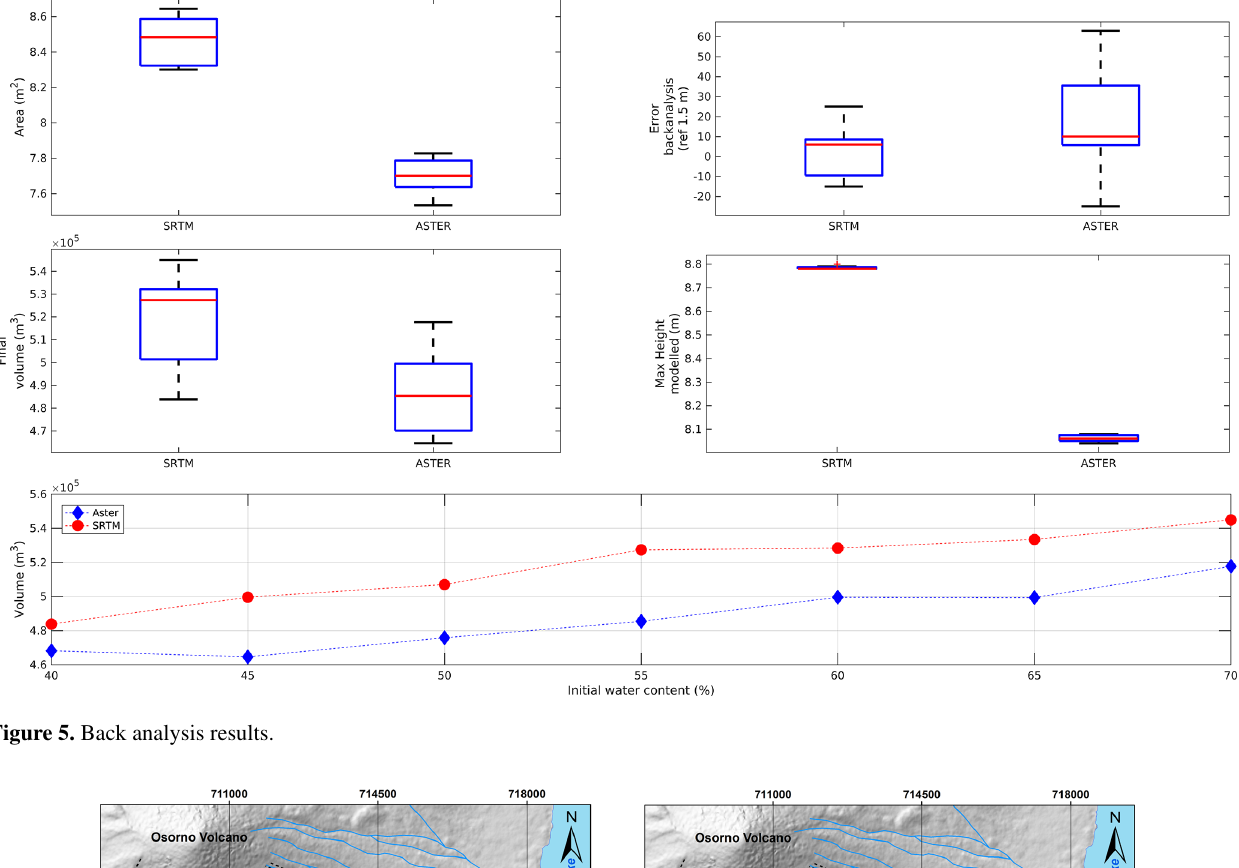
Figure 5. Back analysis results.